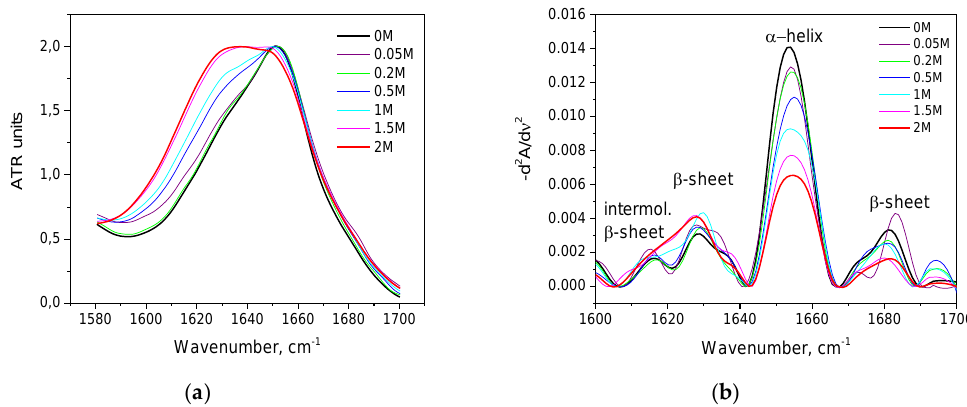
Figure 2. Changes in the Amide I band ( a ) and changes in the second derivative of the Amide I band ( b ) of HSA in 10% wt. aqueous solution at 23 °C with various concentrations of KSCN.